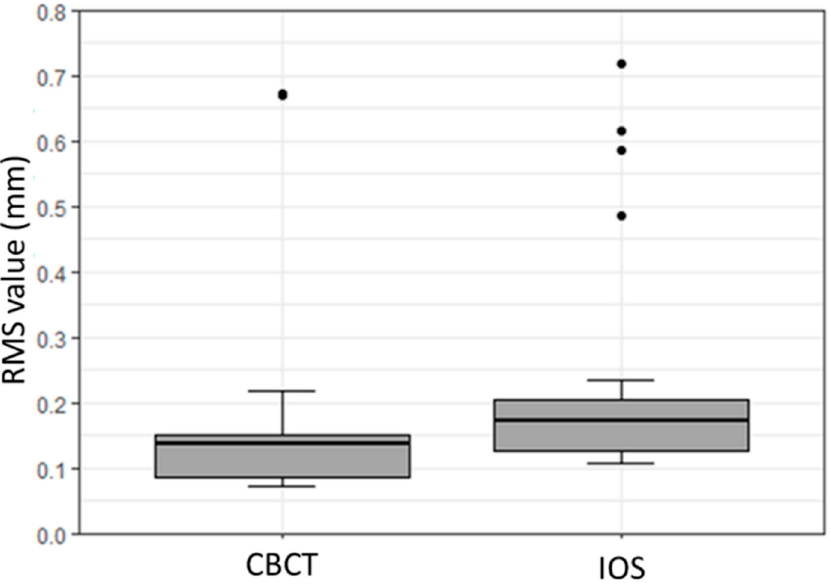
Figure 5. Box plot showing the overall trueness assessment concerning root mean square (RMS) values (mm) for CBCT and IOS.